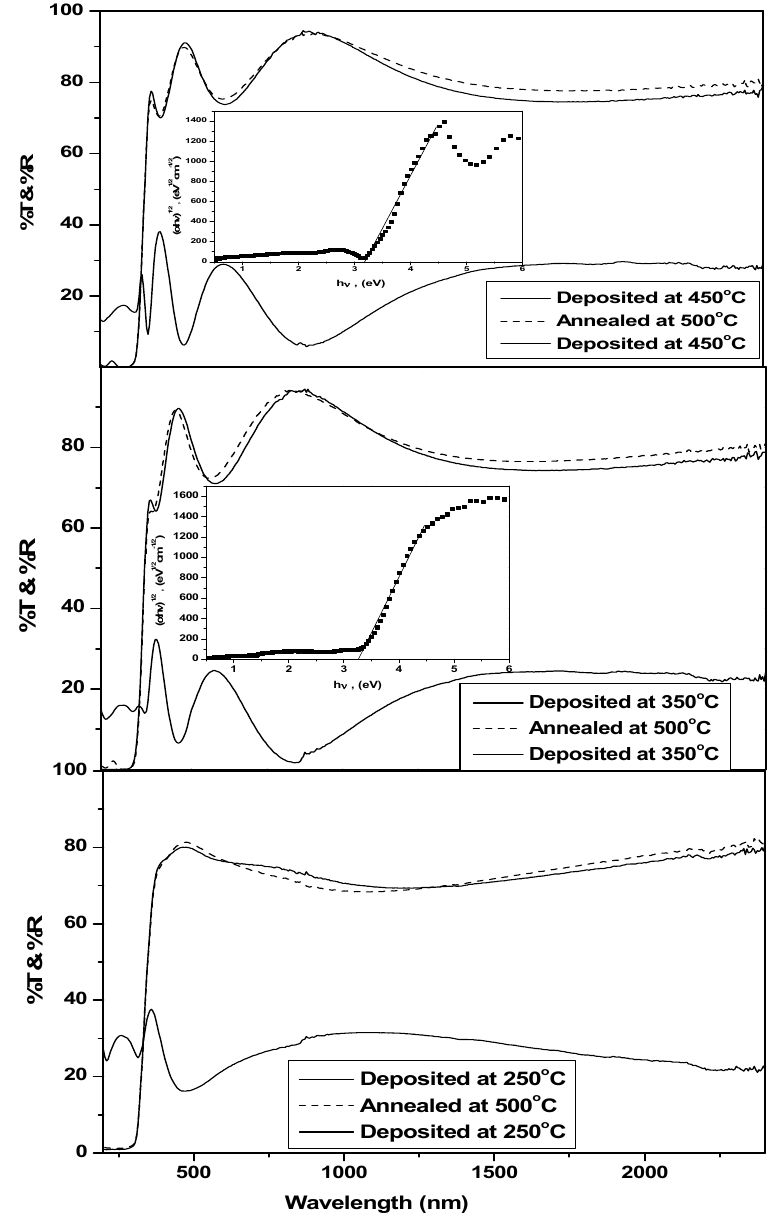
Figure 3. %T of the as-deposited and annealed films and %R of the as-deposited films. Insets show the energy gap calculations of the corresponding films.